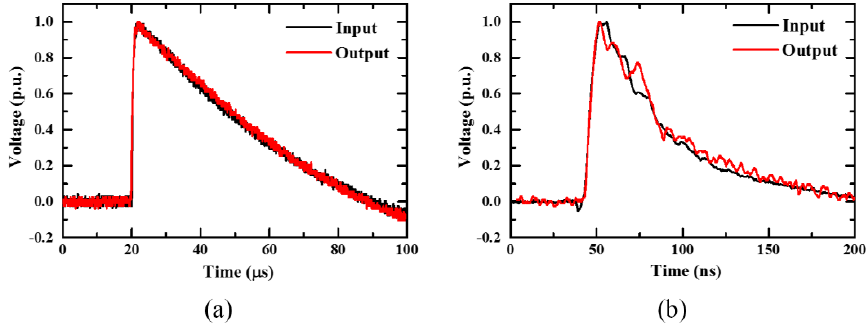
Figure 5. Test results of response speed. ( a ) Lightning impulse; ( b ) electro-magnetic pulse.